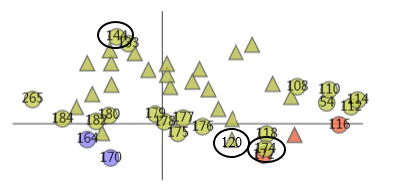
Figure 16. The AAFS Detailed Clustering View shows the distribution of selected amino acids, where the black oval marks the identified allosteric sites. Different colors represent different clusters. The triangles in the plot represent the mapping of cavity-lining amino acids, and the circles represent the mapping of other amino acids.